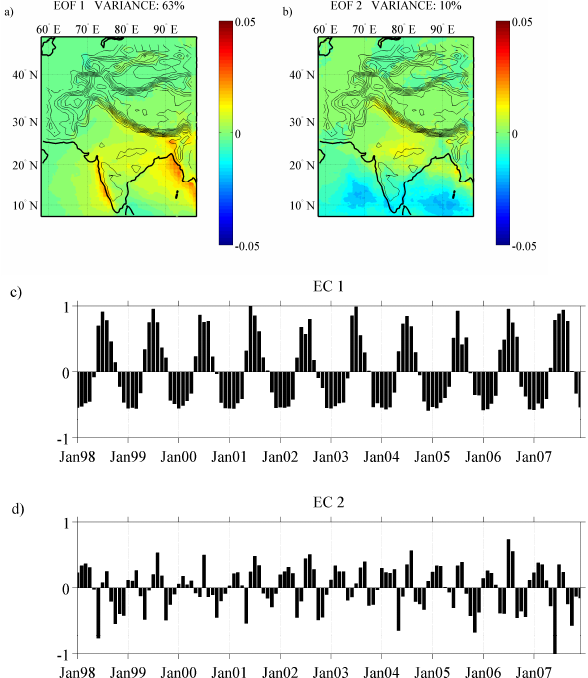
Fig. 6. (a, b) EOF 2 and EOF 3 from MODIS AOD using the com- Figure 6: a,b) EOF 2 and EOF 3 from MODIS AOD using the combined product of dark bined product of dark target approach and deepblue algorithm. (c, target approach and deepblue algorithm. c,d) EC2 and EC3 of the corresponding spatial patterns d) EC2 and EC3 of the corresponding spatial patterns of EOF2 and EOF3 of MODIS AOD respectively. of EOF2 and EOF3 of MODIS AOD respectively.